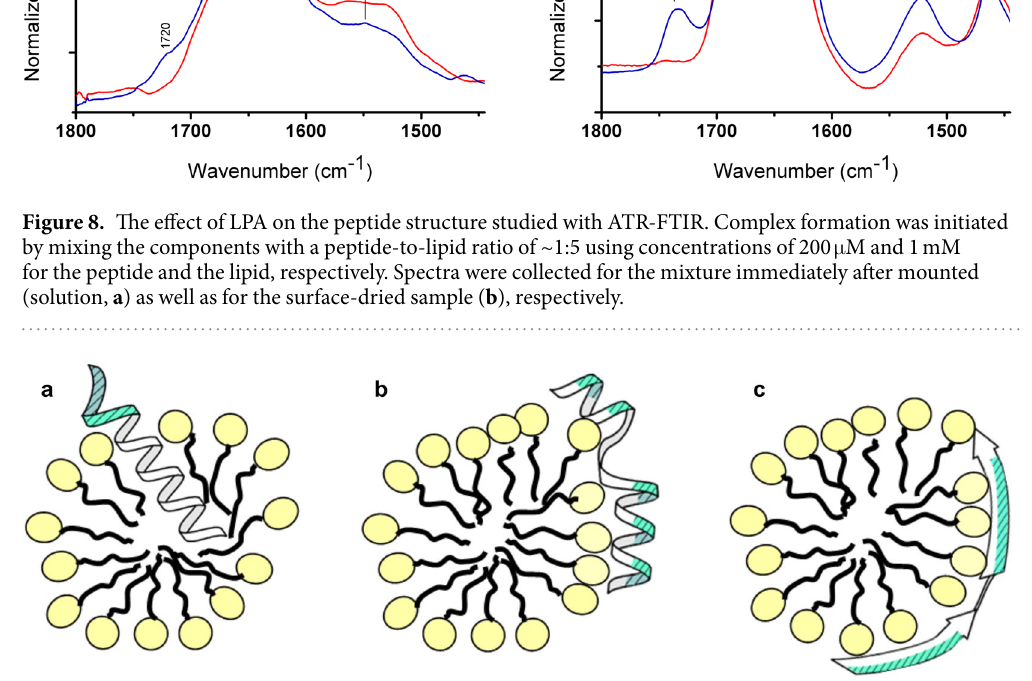
Figure 9. Schematic model showing three possible arrangements for the investigated set of peptides upon interaction with LPA micelles. ( a ) A peptide in inserted helix conformation, ( b ) a peptide in helical conformation associating with the micelle, ( c ) a peptide in extended, sheet-like conformation. Note that in cases b and c , peptide hydrophobic side chains are most likely inserted into the more lipophilic area, beyond the headgroup region of the micelles. Location of hydrophilic residues is highlighted by dashed cyan fill on the corresponding side of the formed secondary structure. For the complete set of peptides and their side chain distribution upon forming helical or extended sheet-like conformation, see Fig. S4 in Supplementary